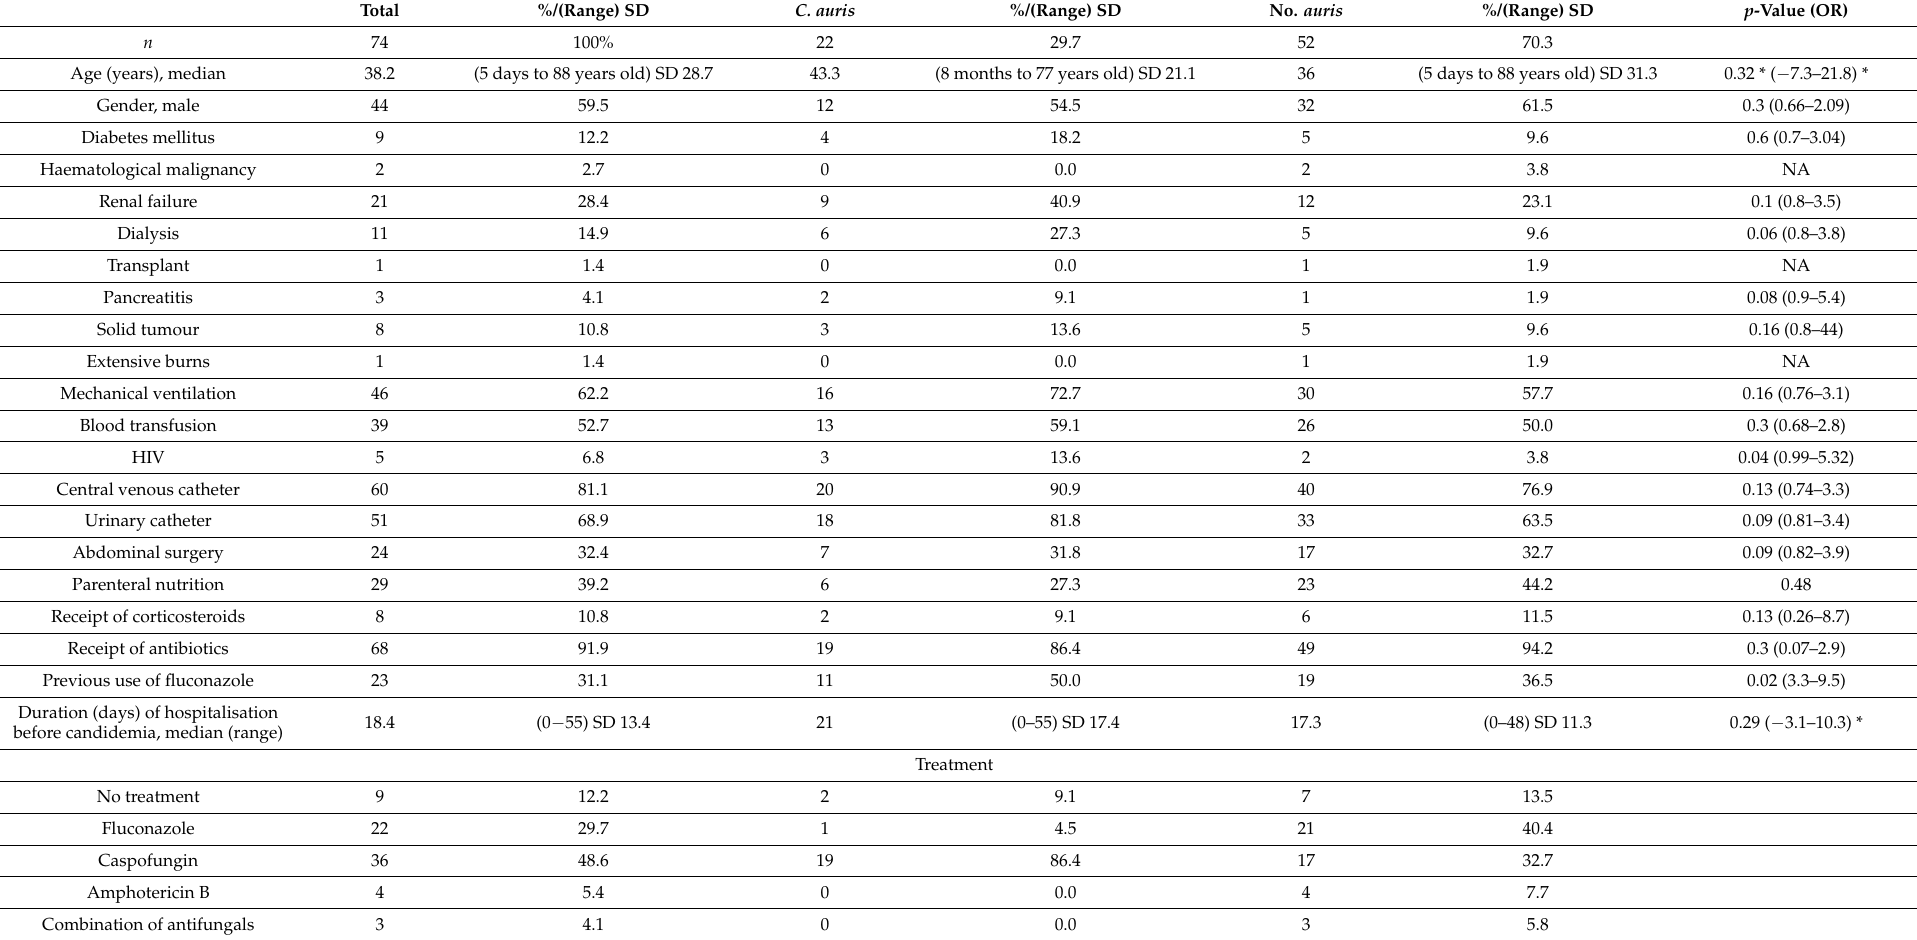
Table 1. Epidemiological and demographic characteristics, underlying conditions, treatments and outcomes of patients with fungemia in 12 hospitals in Valledu- par,